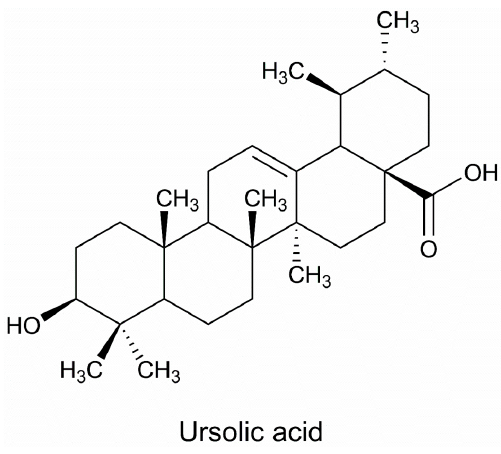
Figure 1. Chemical structure of ursolic acid.